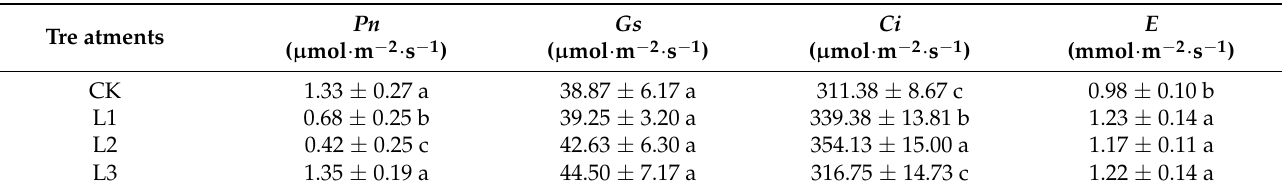
Table 5. Effects of different light qualities on photosynthetic parameters of ‘Misty’ in plant factory with artificial lighting.